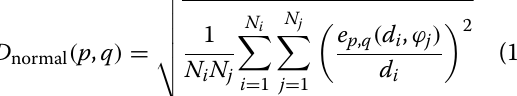
Fig. 5 Proposed equipping method for relative position and